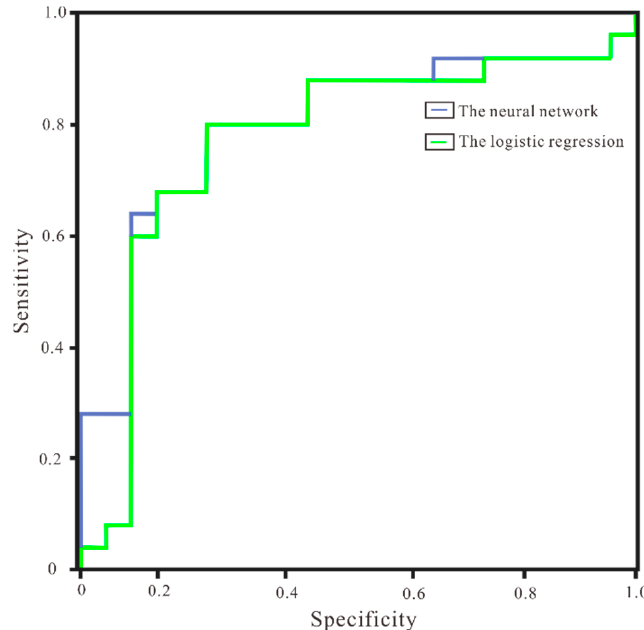
Figure 8. The ROC curve analysis.